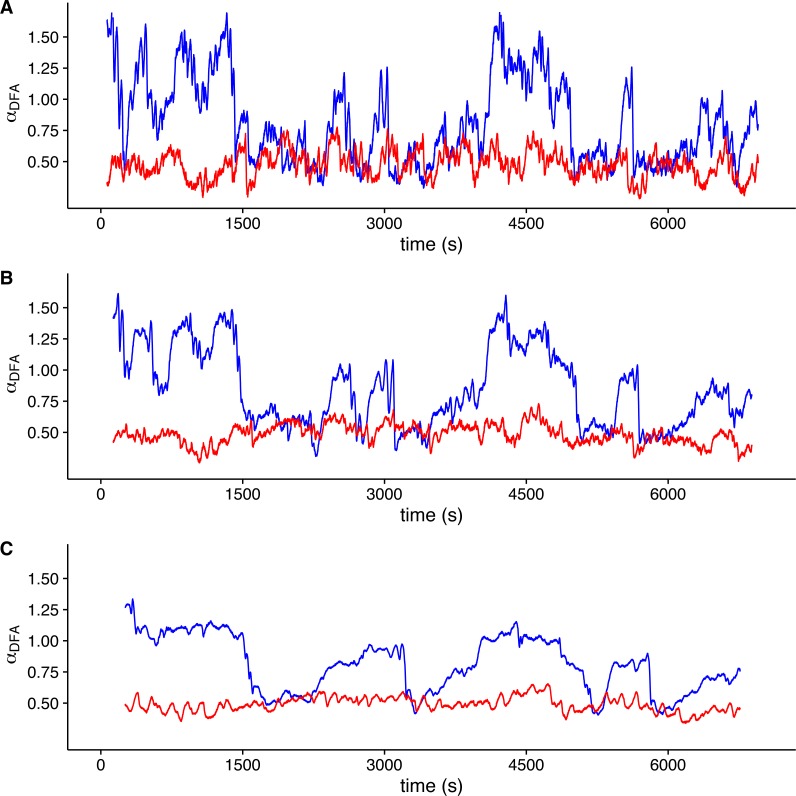
Local DFA scaling exponents.The figure shows the value of local DFA scaling exponents αDFA for the time series in Figs. 1C (blue lines) and 1D (red lines). Local exponents are calculated with a moving window shifted across the whole time series. Figures (A), (B) and (C) show the results for shifting window widths of 128, 256 and 512 s respectively. The heterogeneity of the rate of change in metabolic rate is revealed by the broad range of local scaling exponents αDFA, which shows a complex structure in time as opposed to the simpler and more restricted changes in the shuffled time series.